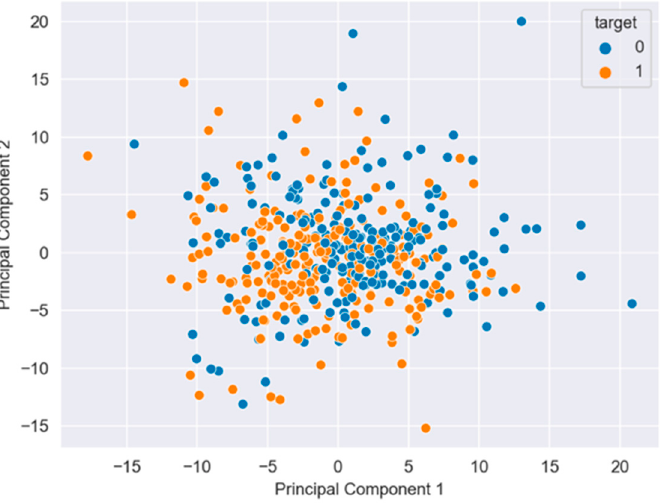
Figure 6. The PCA analysis shows the dispersion and independence between two 0 and 1 classes.